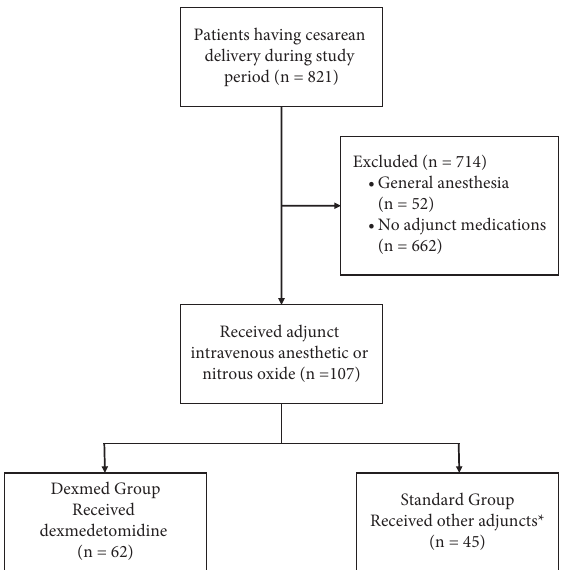
Figure 1: Flowsheet of patient inclusion and exclusion. Flow di- agram of patient selection. ∗ Fentanyl, midazolam, ketamine, ni- trous oxide, propofol, or a combination of these